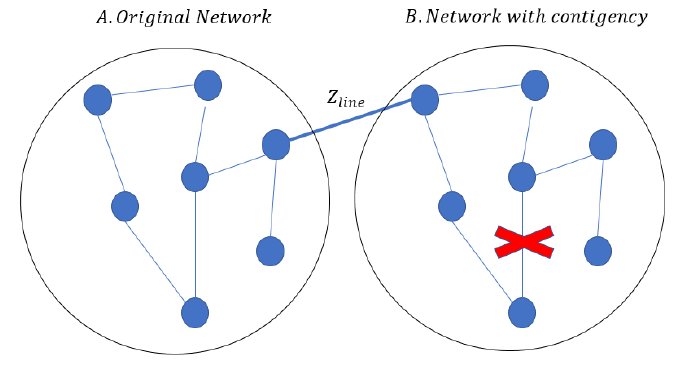
Figure 3. Topology approach to find the CCOPF through traditional OPF